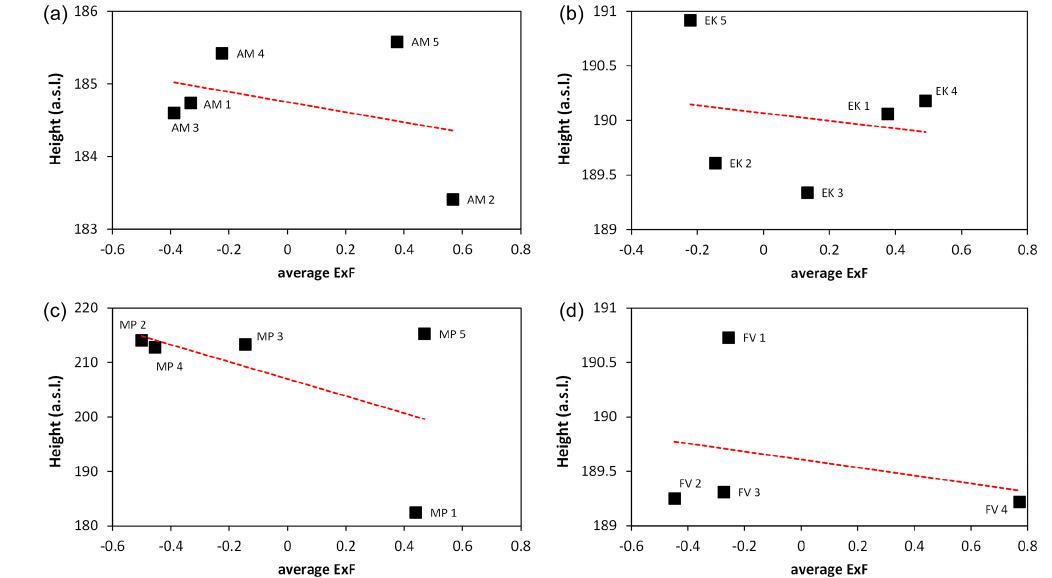
Figure 3. Exposure factor (ExF) according to sampling point height (metres above mean sea level) for all sampling sites with significant height differences. (a) Sampling site AM; (b) sampling site EK; (c) sampling site FV; (d) sampling site MP. Linear trend is shown as a red dashed